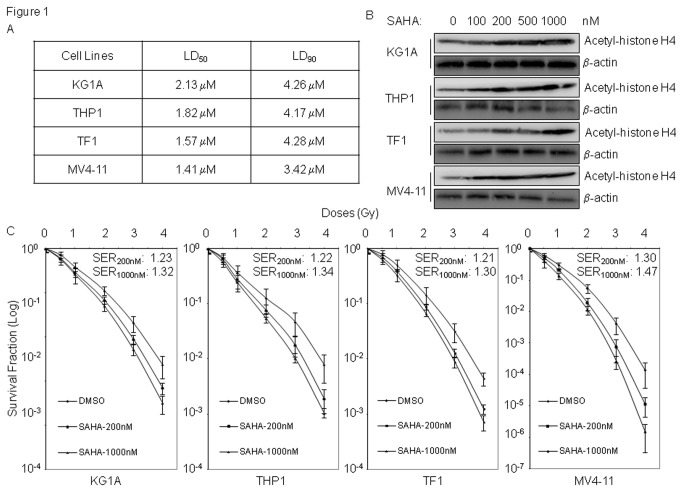
SAHA induces radiosensitization in AML cells.(A) LD50/LD90 values of SAHA on AML cells. AML cells were exposed to various concentrations of SAHA, and plated in methylcellulose medium for colony formation. LD50/LD90 values were determined based on the survival colonies. Data represent the average results from three independent experiments. (B) SAHA induces histone H4 acetylation. AML cells were exposed to SAHA for 16 hours. Whole cell extracts were prepared and analyzed by immunoblot assay for acetylation of histone H4. Anti-actin antibody was included for loading control. (C) SAHA induces radiosensitization in AML cells. AML cells in log phase were pretreated with 200nM or 1 μM of SAHA for 16 hours, and then irradiated at indicated doses. Clonogenic survival assays were performed in methylcellulose medium as described in materials and methods. Data represents the average of three experiments. Error bars indicate standard deviation.